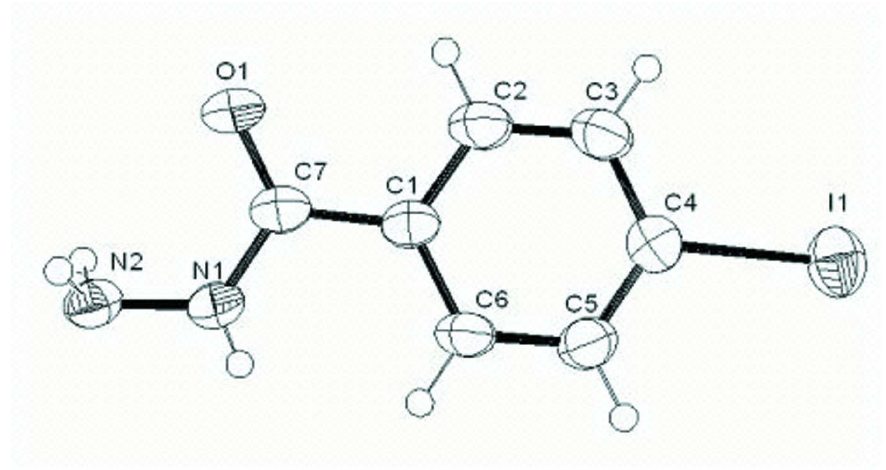
Figure 1 ORTEP plot of the title compound with the ellipsoids drawn at the 50% probability